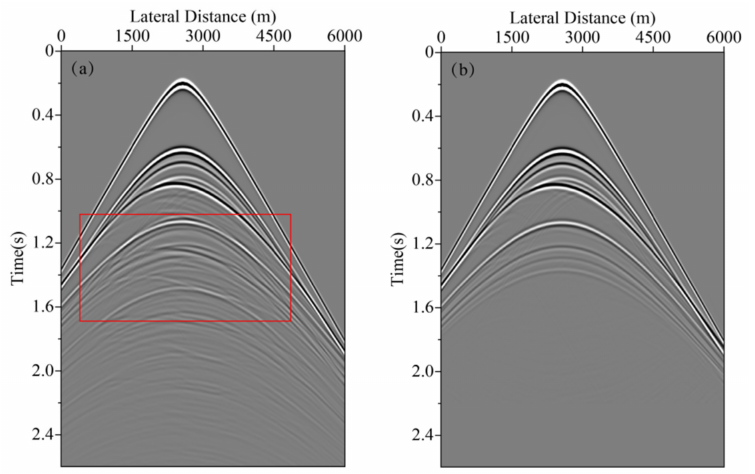
Figure 10. Syncline velocity model.